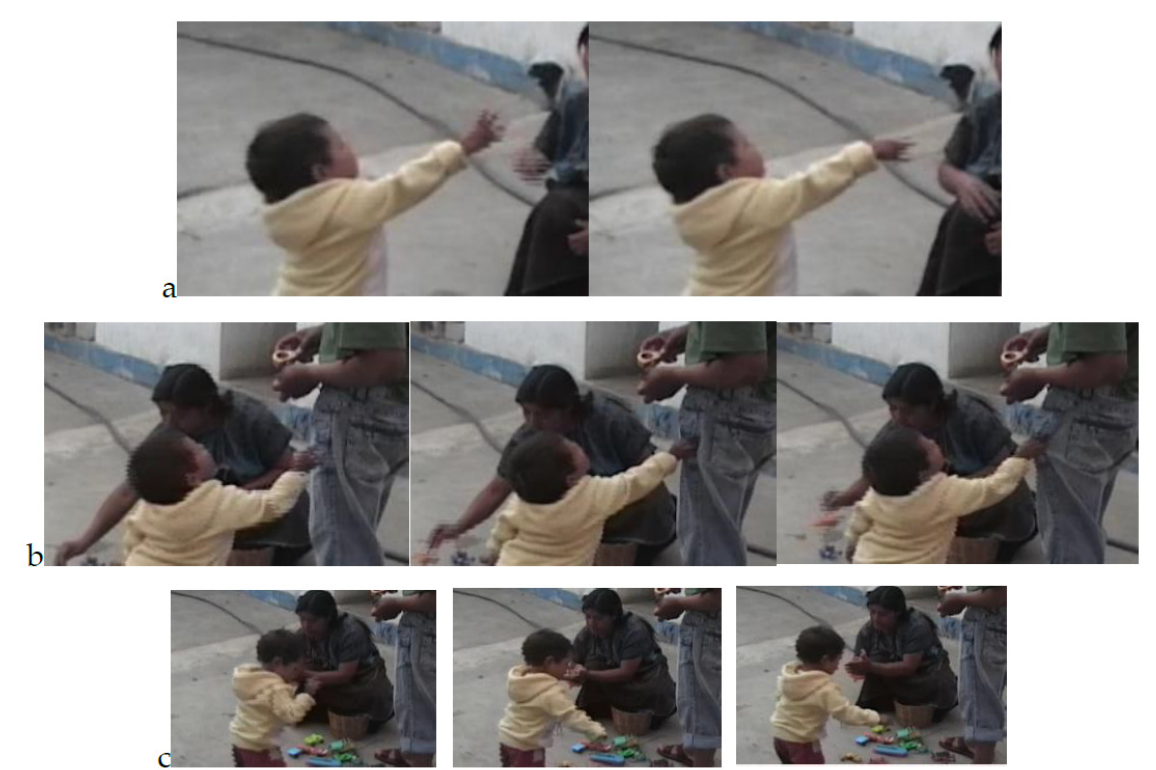
Figure 18. Vic, 22 mos., signed and grabbed to ask his uncle to sit. ( a ) Vic tried first a HEY1 sign (extended palm and multiple downward flips with his fingers) to Frank, before ( b ) he resorted to pulling on Frank’s trousers and ( c ) asking him to launch a wooden top onto the ground.